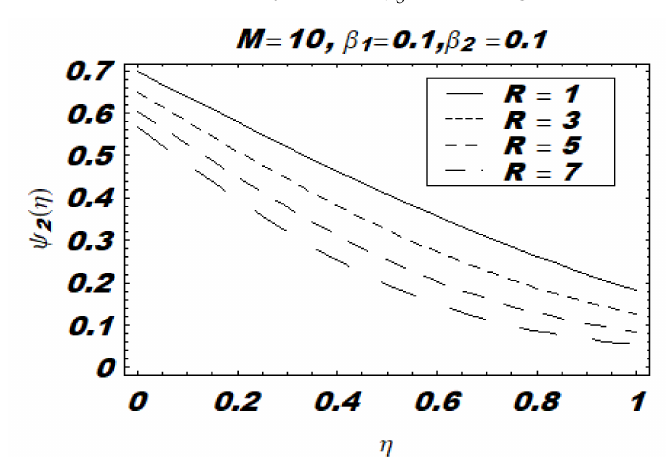
for the long slider. 3